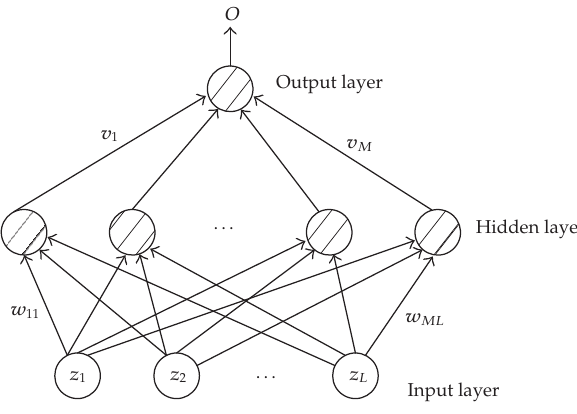
Figure 1: CVVN with L − M − 1